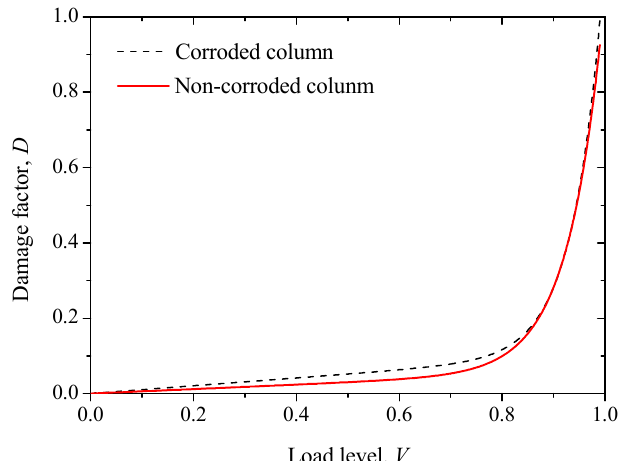
Figure 20. The modeled relationships between the load level and the damage factor for corroded and non-corroded RC